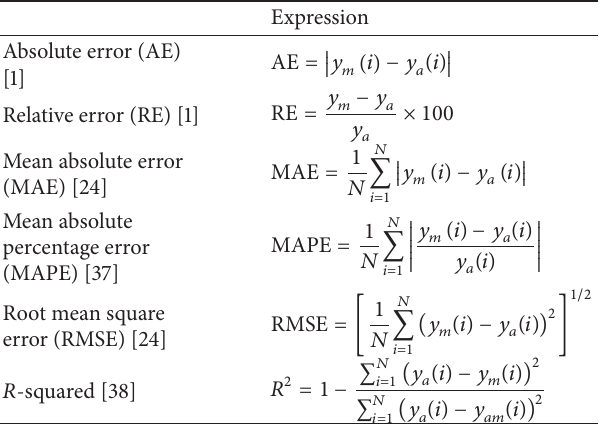
Table 2: Model evaluation